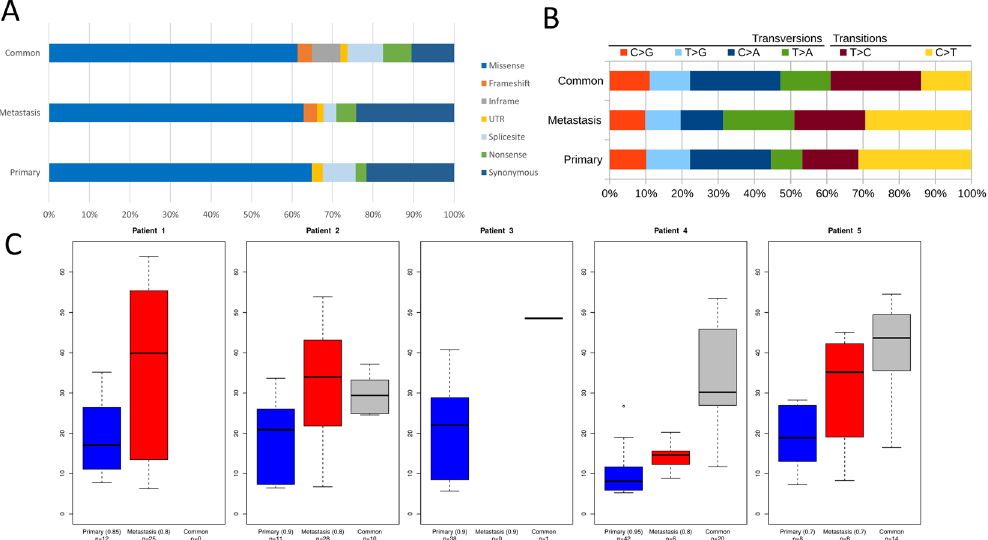
Figure 1. Mutational characteristics. Mutational details of exome sequencing of primary and metastatic samples of Patient 1–5. ( A ) Mutational categories according to mutations found only in the metastasis sample, only in the primary sample or in both samples (common). ( B ) Distribution of transversions and transitions according to presence in primary, metastasis or both (common). ( C ) Distribution of allele frequencies (AF) of mutations detected only in the primary lesion, only in the metastasis, or in both samples (common). Observed allele frequencies were scaled to account for estimated tumor content (given in